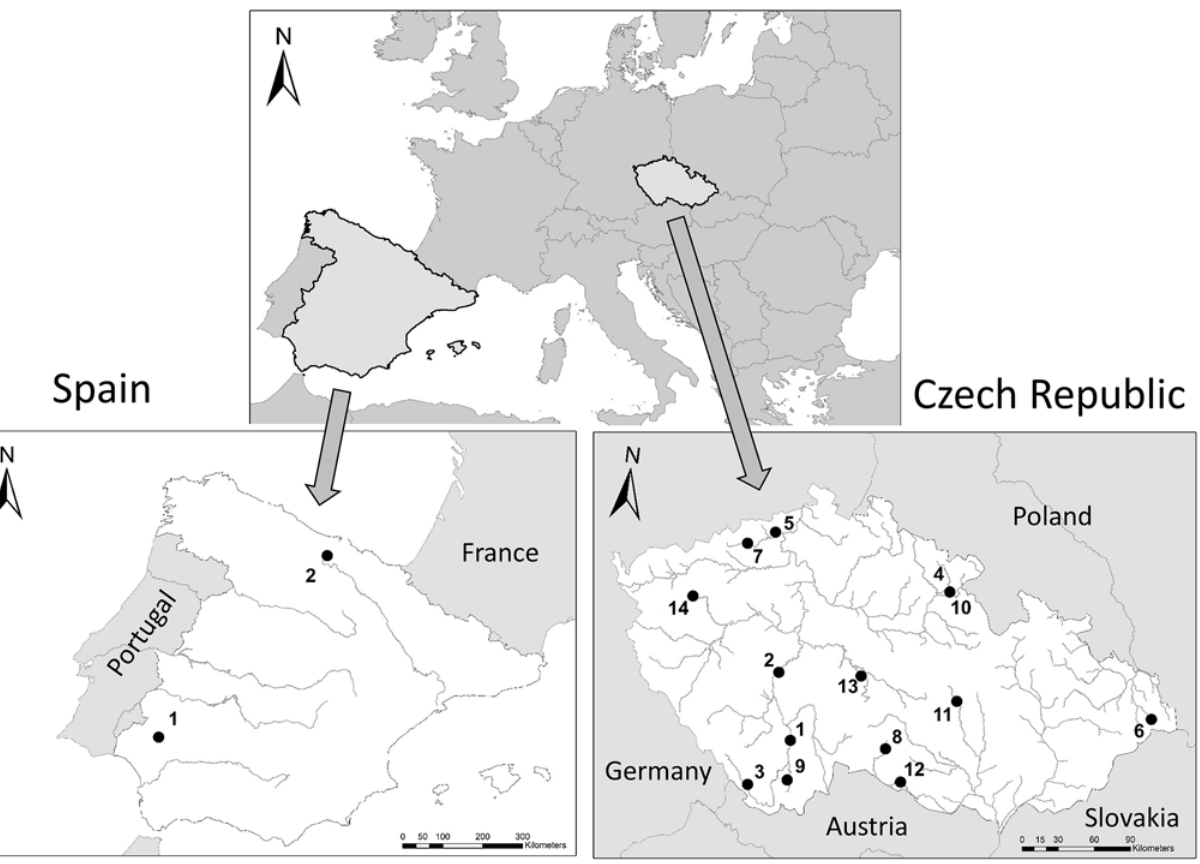
Fig 1. Map of the Czech Republic and Spain showing the locations of the water bodies sampled in this study. Reservoirs located in Spain: 1 — Aracena, 2 — Ebro. Reservoirs and lake located in the Czech Republic: 1 — Hn ě vkovice, 2 — Kamýk, 3 — Lipno, 4 — Malá Rozko š 5 — Milada, 6 —